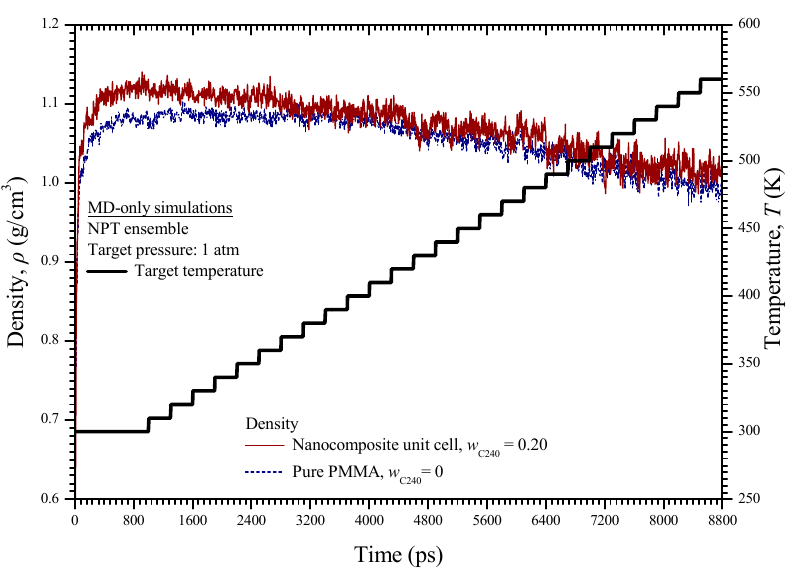
Figure 6. Density of the pure PMMA and nanocomposite with w C240 = 0.2 versus time in contrast with the time-dependent temperature during the MD simulations.